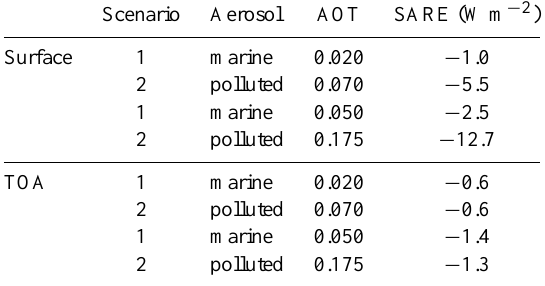
Table 3. Results of radiative-transfer calculations for different aerosol optical thickness (AOT). Pure marine and polluted aerosol conditions were simulated for a surface albedo of 0.2 at 0 ◦ latitude and longitude in spring (on 15 April). The settings for both sce- narios are given in Table 1. TOA and SARE denote the top of the atmosphere and the 24h averaged solar aerosol radiative